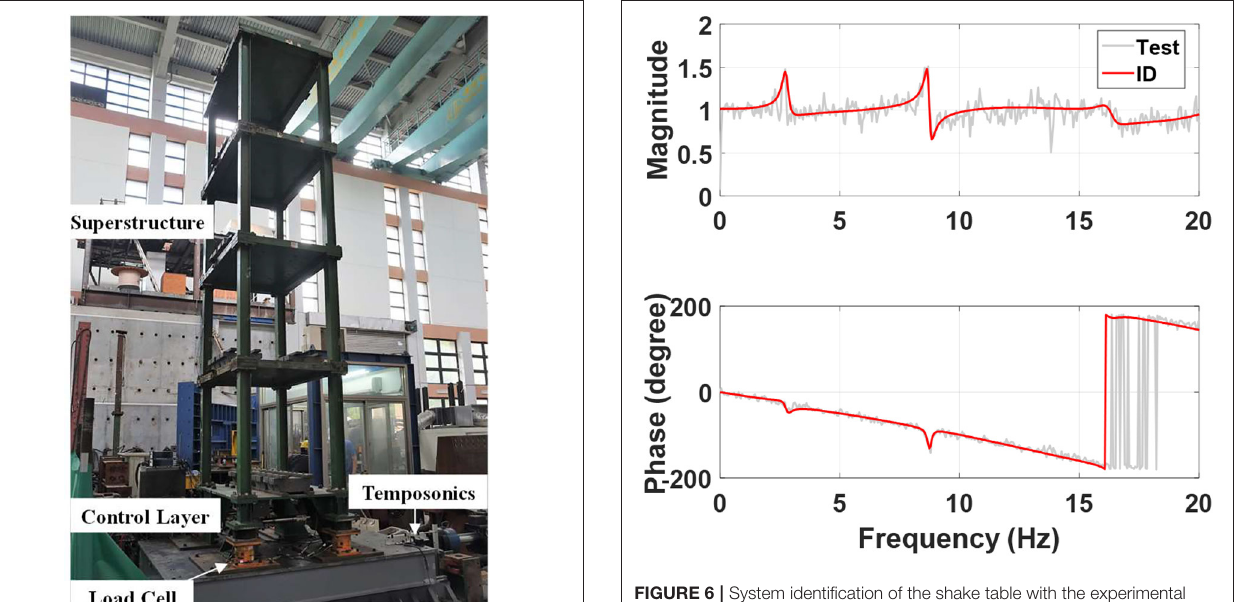
FIGURE 6 | System identification of the shake table with the experimental substructure.